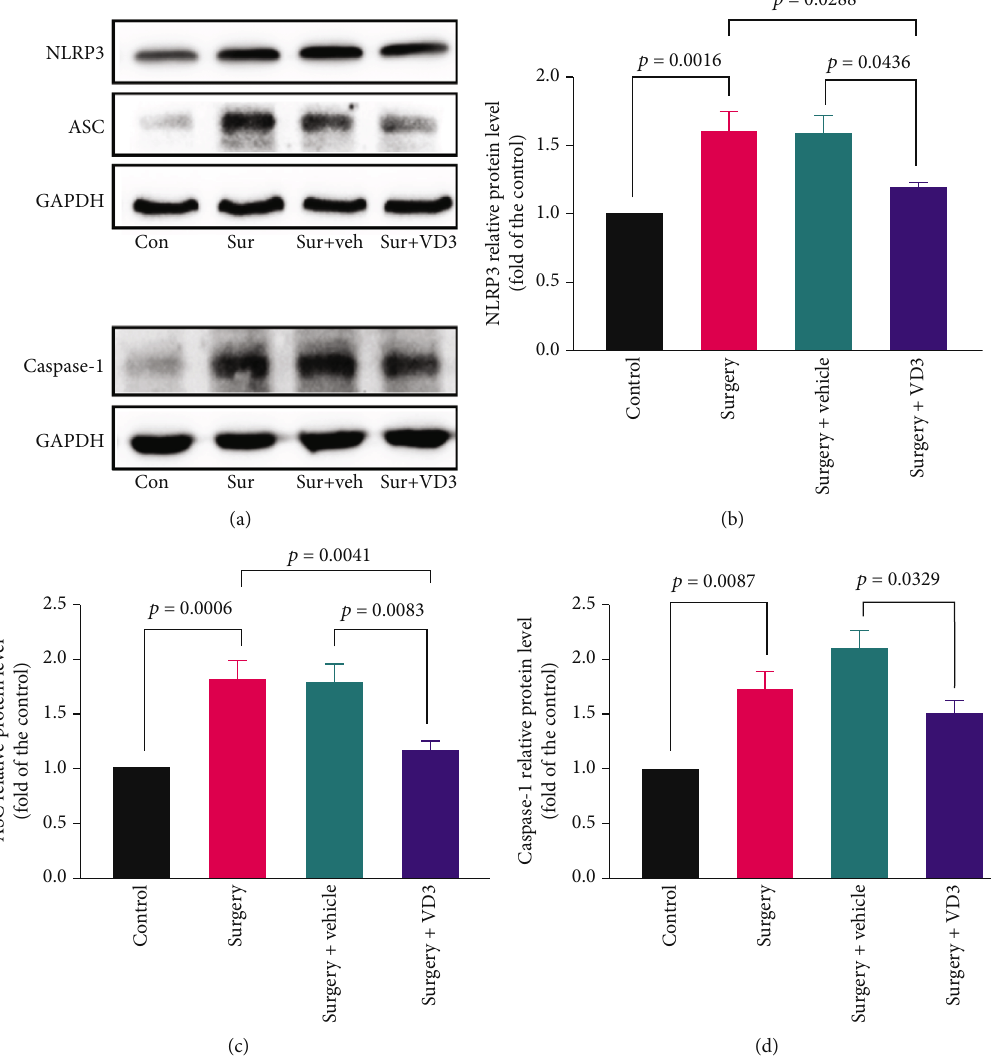
Figure 4: Expression levels of NLRP3, ASC, and caspase-1 in the hippocampus 24 hours after surgery. Western blot (a) and quantitative results (b – d) regarding the expression of NLRP3, ASC, and caspase-1. Data are presented as means ± SD ( n = 5 per